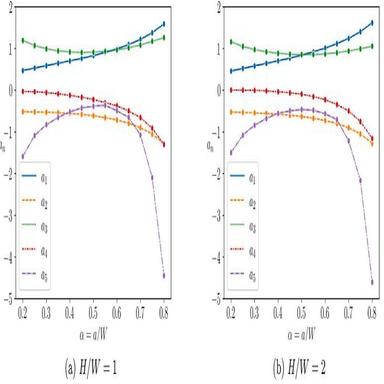
Normalized Williams coefficients 1 , … , 5 for the MT-specimen parameter study over the whole crack length .